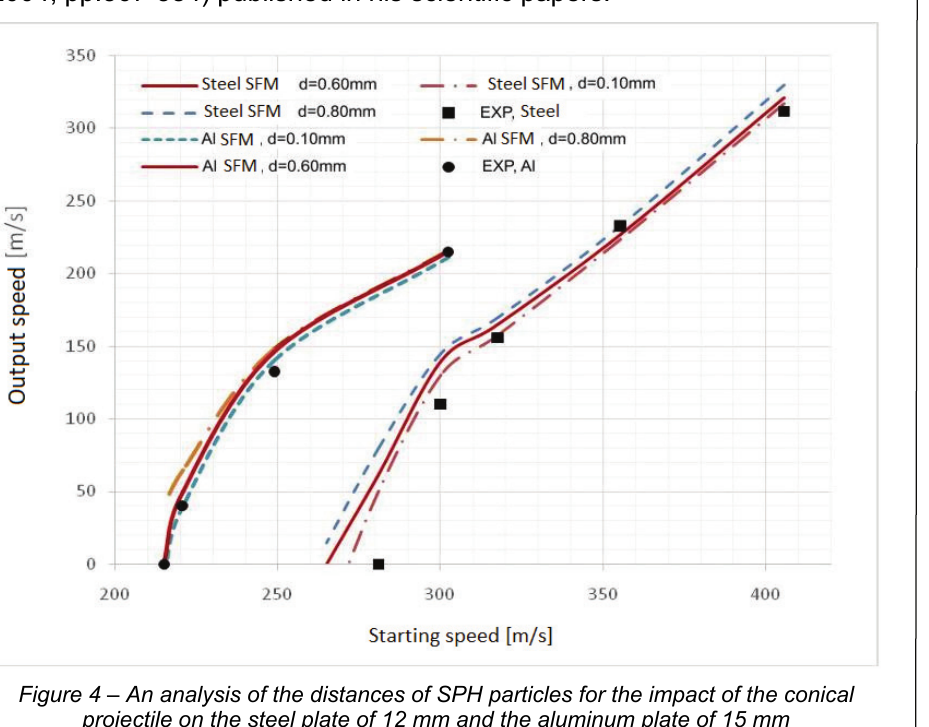
Figure 4 – An analysis of the distances of SPH particles for the impact of the conical projectile on the steel plate of 12 mm and the aluminum plate of 15 mm Рис . 4 – Анализ расстояния SPH частиц от удара остроконечного снаряда о стальную плиту 12 мм и алюминиевую плиту 15 мм Слика 4 – Анализа удаљености СПХ честица за удар конусног пројектила